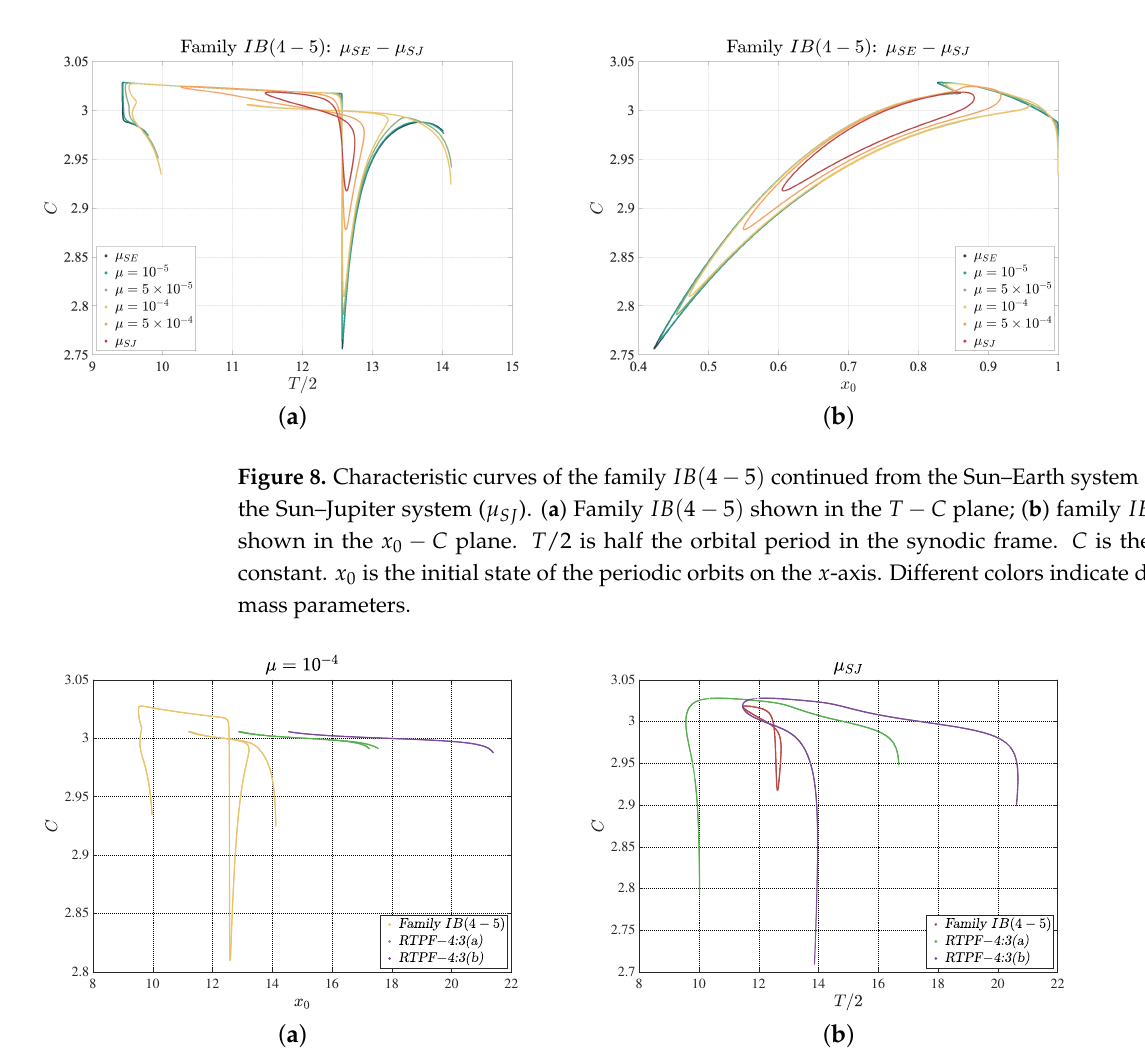
Figure 9. Characteristic curves of the family IB ( 4 − 5 ) and two RTPFs for the system with µ = 10 − 4 ( a ) and µ = µ SJ ( b